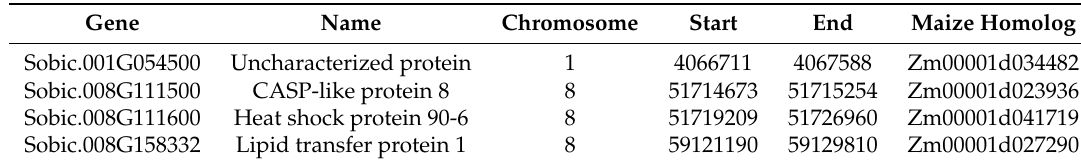
Table 2. Potential candidate genes from the significantly associated regions.